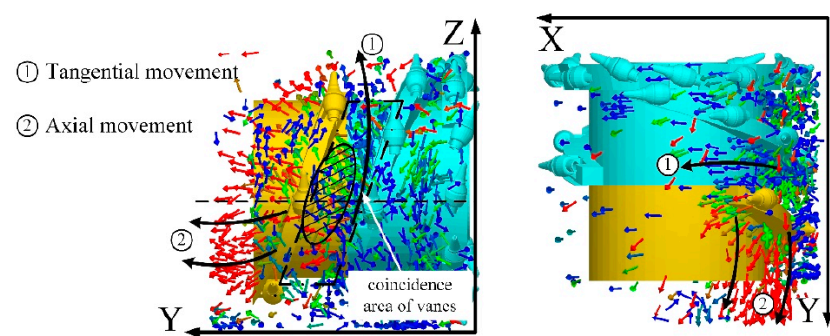
Figure 14. The schematic under the condition of n F = 45 rpm, n R = 75